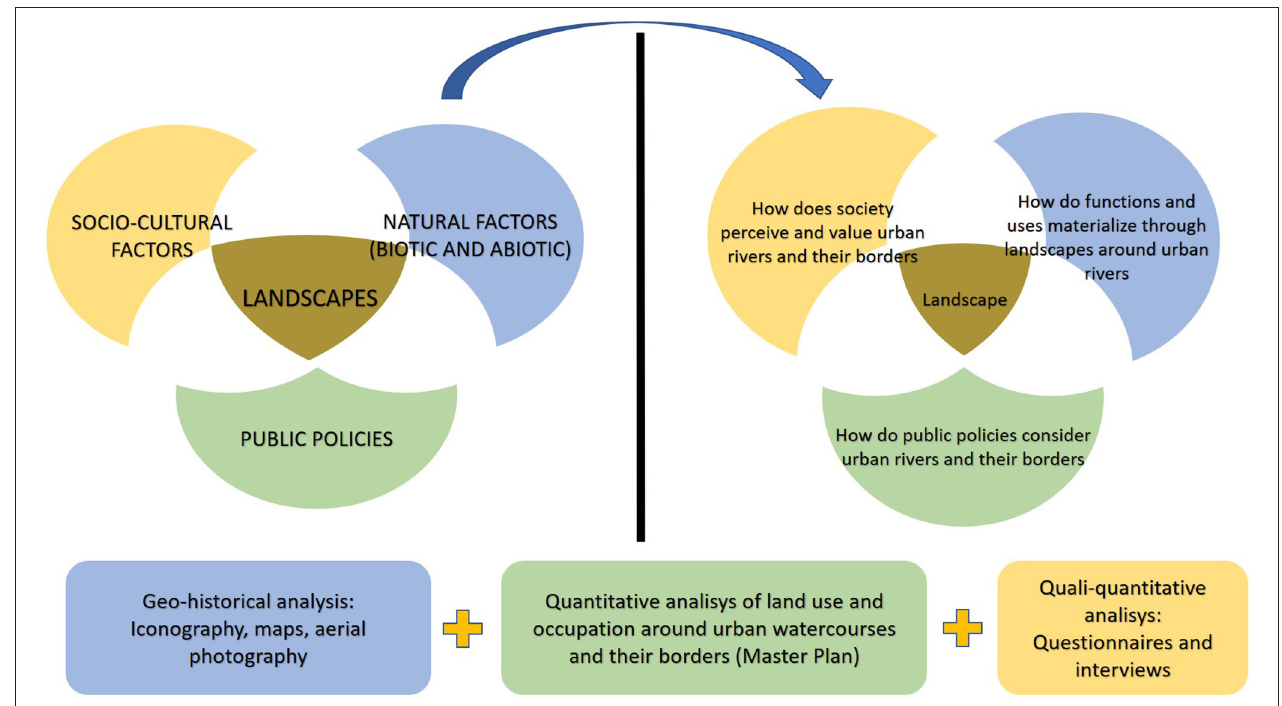
FIGURE 2 | Methodological scheme. Source: Sousa R. B. et al. (2021).